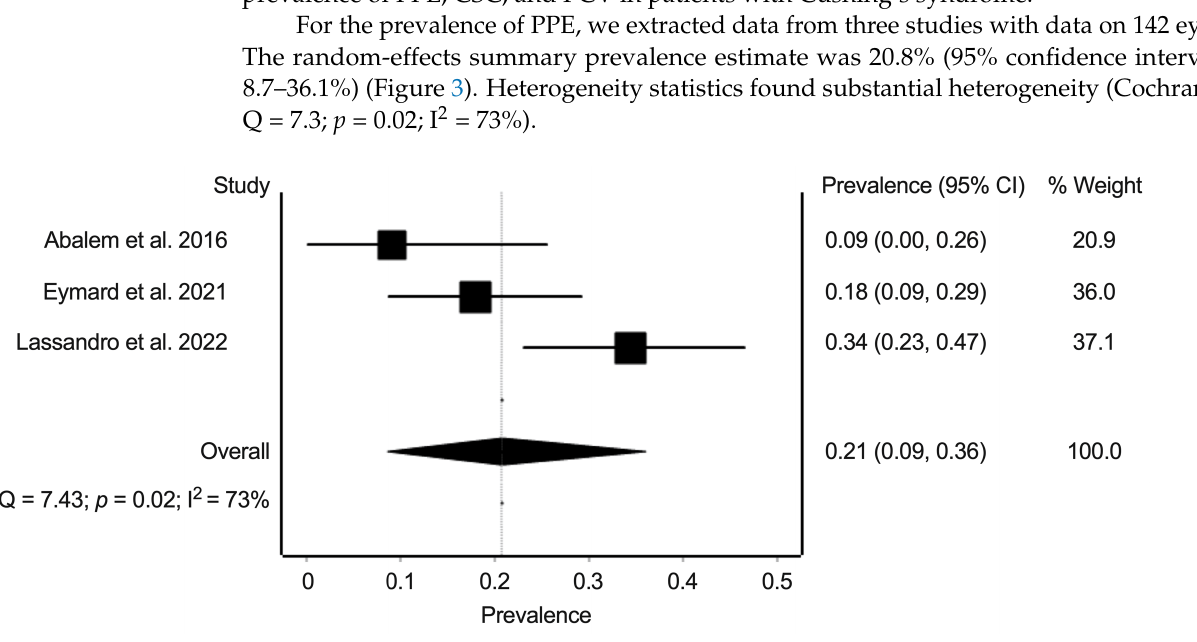
Figure 3. Meta-analysis of the prevalence of pachychoroid pigment epithelium in eyes of patients with Cushing’s syndrome. Prevalence numbers are indicated in decimals [15,17,19].